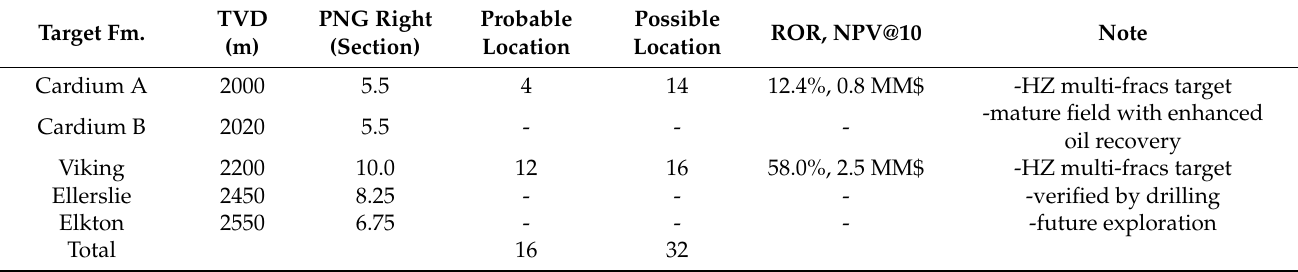
Table 5. Development potential summary in the Crossfield study